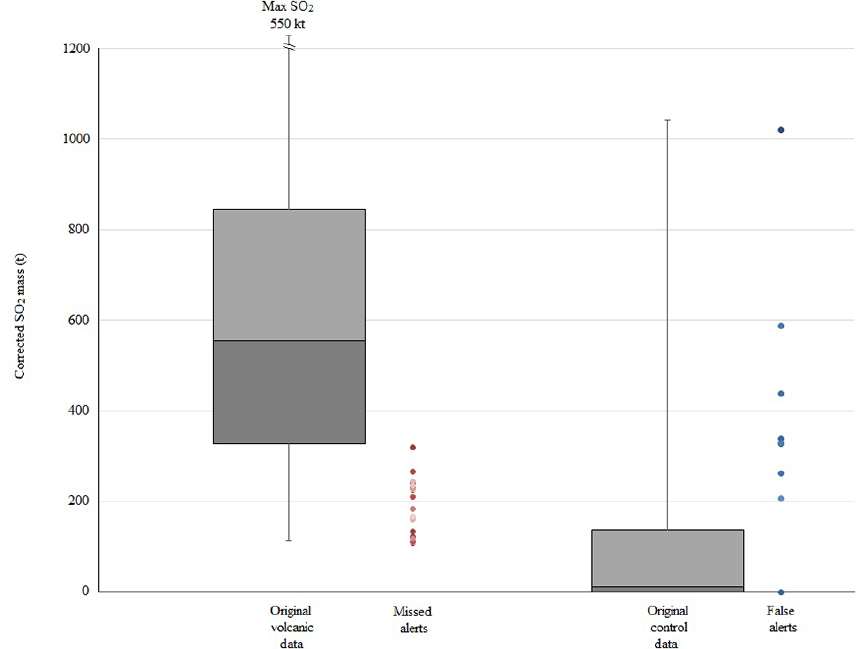
Figure 2. Box-and-whisker plots displaying the spread and distribution of volcanic and control data, with lines indicating upper and lower quartiles of the data and the remainder represented by the box region. Additional data points indicate the individual missed alerts in the volcanic data and false alerts in the control data detailed in Table